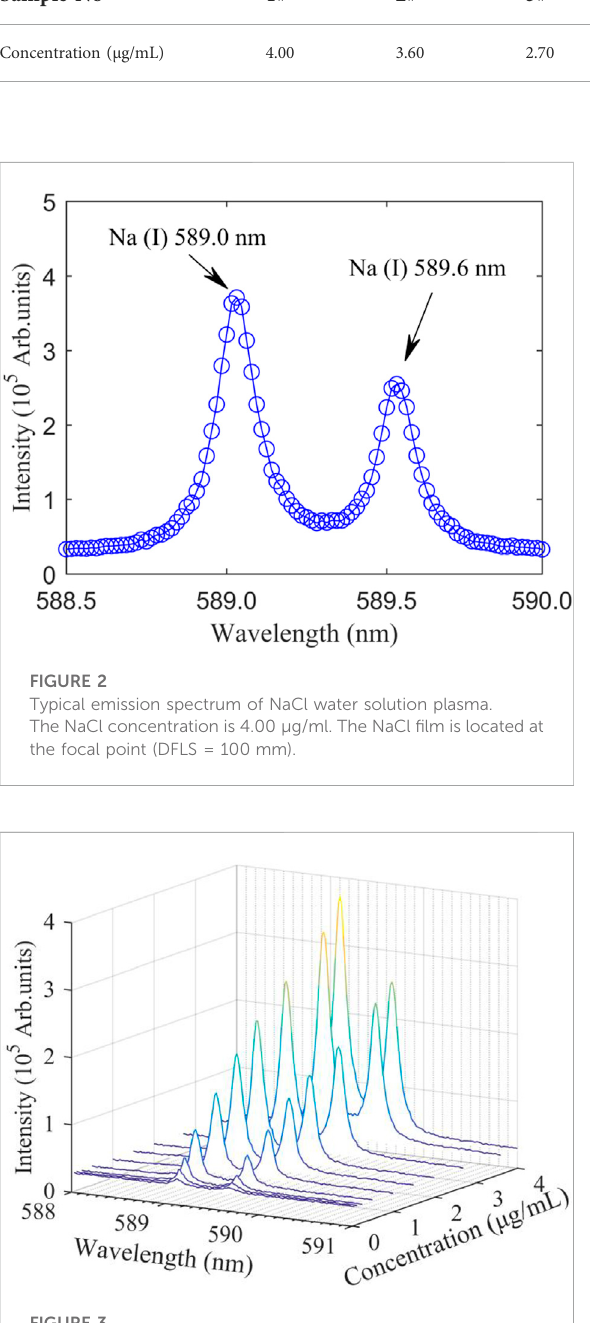
FIGURE 3 Evolution of Na atomic lines from laser-induced plasma with NaCl concentration of. The NaCl fi lm is located at the focal point plane (DFLS = 100